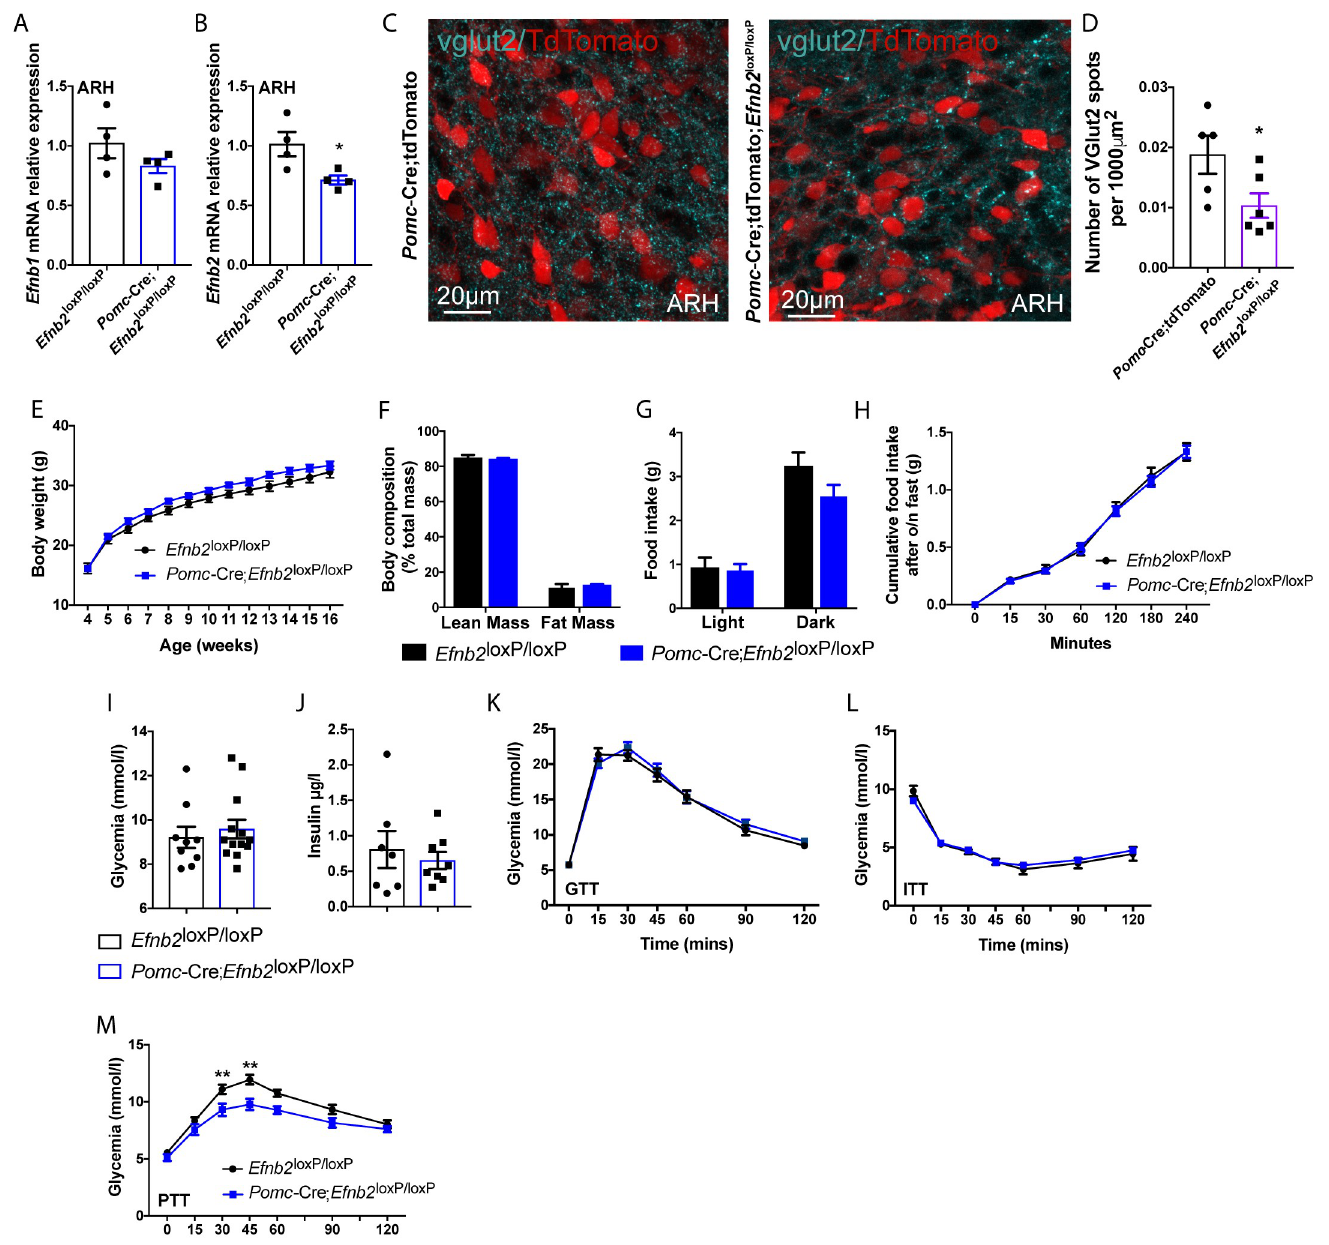
Fig 7. Loss of Efnb2 in POMC-expressing progenitors causes impaired gluconeogenesis in males. Efnb1 (A) and Efnb2 (B) mRNA relative expressions in ARH of adult Efnb2 loxP/loxP and Pomc -Cre; Efnb2 loxP/loxP male mice ( n = 4/group). (C) High magnification of vGLUT2-positive terminals into POMC-expressing progenitors (red) in Pomc -Cre;tdTomato control and Pomc -Cre; Efnb2 loxP/loxP ;tdTomato mutant male mice. (D) Quantification of vGLUT2-positive inputs in direct apposition with Pomc -Cre;tdTomato neurons (red) in female mice ( n = 3/group, 2 sections/animal). (E) Post-weaning growth curve of Efnb2 loxP/loxP and Pomc -Cre; Efnb2 loxP/ loxP male mice ( n = 11–14/group). (F) Body composition of 16-week-old male mice ( n = 7–12/group). (G) Food intake of 13–14-week-old male mice ( n = 6–10/ group). (H) Refeeding after overnight fasting of 13–14-week-old male mice ( n = 13–15/group). (I) Basal glycemia of 8-week-old male mice ( n = 9-13/group). (J) Basal insulinemia of 16-week-old male mice ( n = 7-8/group). (K) Glucose tolerance test of 8–9-week-old male mice ( n = 11–13/group). (L) Insulin tolerance test of 14-week-old male mice ( n = 7–12/group). (M) Pyruvate tolerance test of 12–13-week-old male mice ( n = 11–13/group). Data are shown ± SEM. Statistical significance was determined using 2-way ANOVA (D–G; J–L) and 2-tailed Student t test (A, B, D; I, J). � P � 0.05 versus Efnb2 loxP/loxP (B) and versus Pomc -Cre; tdTomato (D); �� P � 0.01 versus Efnb2 loxP/loxP (M). The underlying data are provided in S1 Data. ANOVA, analysis of variance; ARH, arcuate nucleus of the hypothalamus; ITT, insulin tolerance test; POMC, proopiomelanocortin; PTT, pyruvate tolerance test; SEM, standard error of the mean.